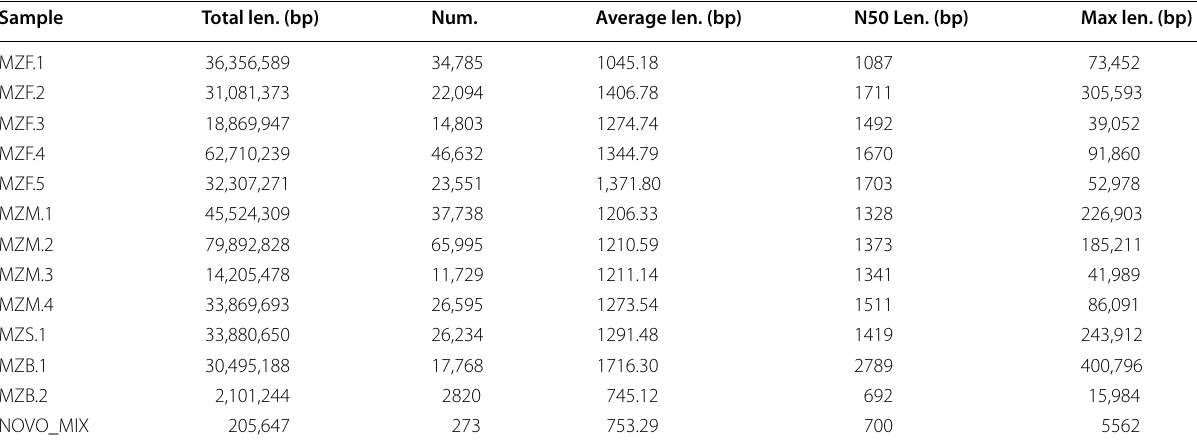
Table 4 The statistical information of sample assembled